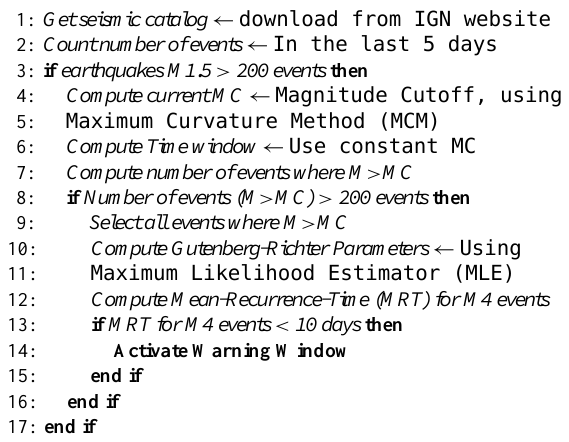
to forecast mainshocks applied during the El Hierro seismo-